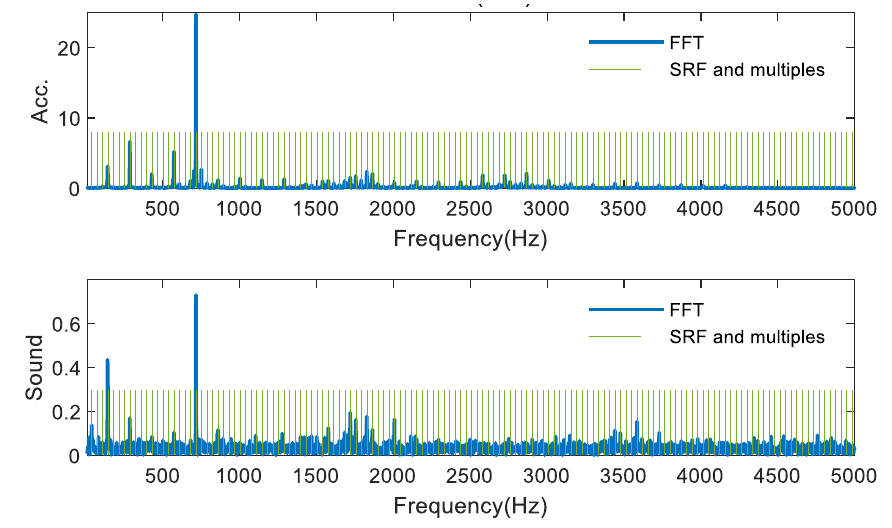
Figure 7. FFT for stable milling state experiments.